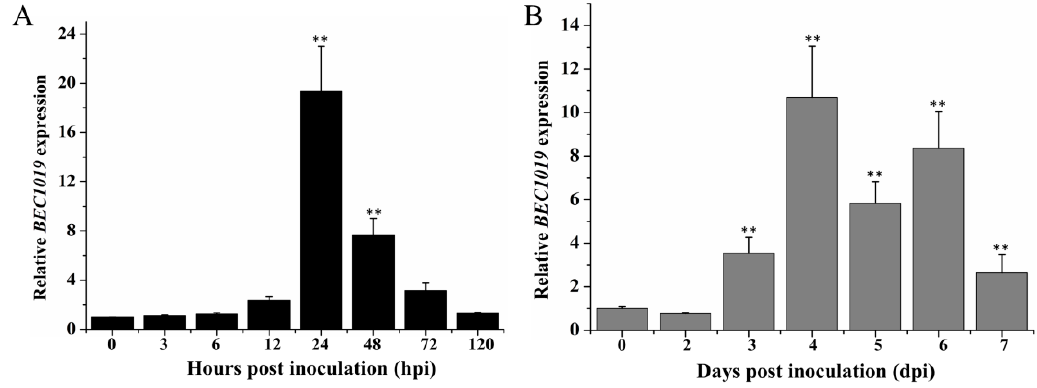
Figure 2. Relative expression patterns of BEC1019 at different stages of Blumeria graminis f. sp. tritici ( Bgt ) and Gaeumannomyces graminis var. tritici ( Ggt ) infection. ( A ) Wheat leaves inoculated with Bgt were harvested at 0, 3, 6, 12, 24, 48, 72, and 120 h post-infection (hpi). ( B ) Wheat roots inoculated with Ggt were harvested at 0, 2, 3, 4, 5, 6, and 7 days post-infection (dpi). The elongation factor 1 α ( ef-1 α ) gene of Bgt and 18S rRNA gene of Ggt were used as control genes for determinations of the relative expression of BEC1019 . Bars indicate the means of three independent biological repetitions with standard errors. Double asterisks indicate significant differences relative to 0 hpi/dpi ( p ≤ 0.01, according to t -tests).